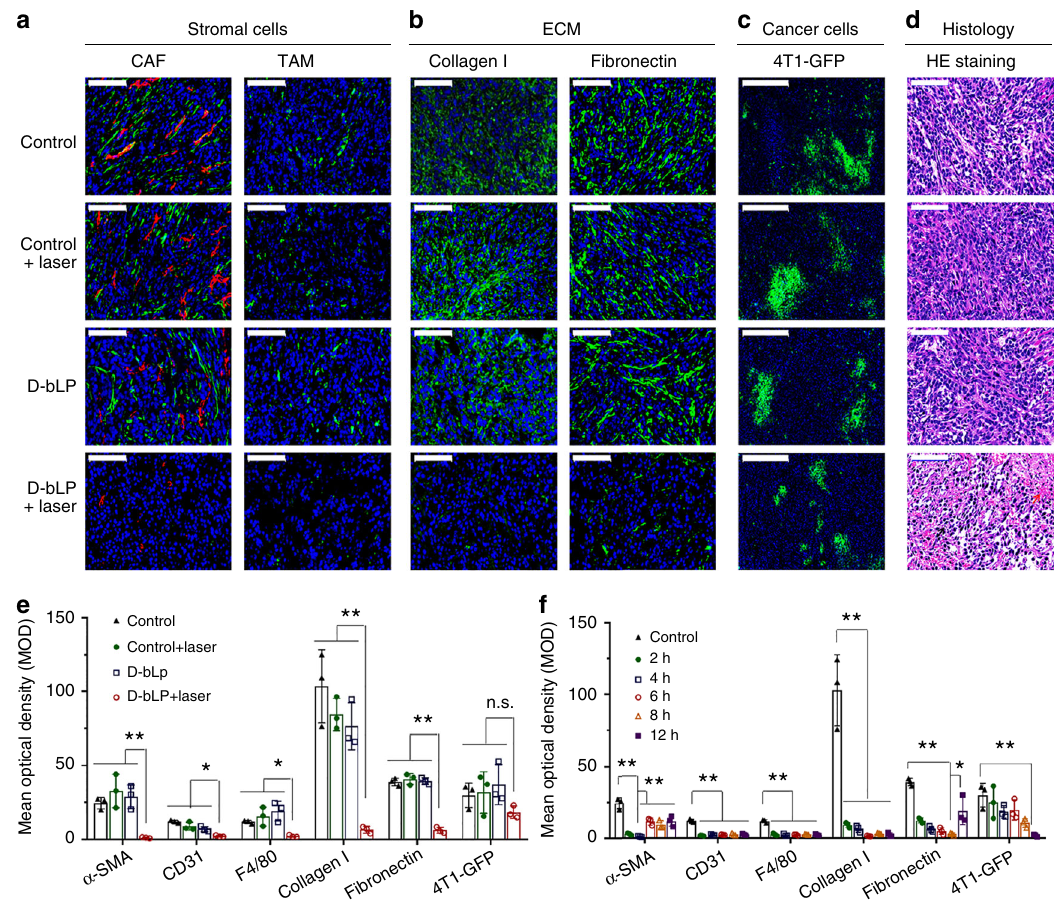
Fig. 4 Ef fi cient remodeling of TSM by D-bLP-mediated photothermal effects. At 12 -h post injection of D-bLP, one tumor was exposed to 808 -nm laser at 2.5 W cm − 2 for 5 min, and the other one was not irradiated. These tumor tissues were collected at 4 h after laser irradiation for further measurements ( a – e ). a Variation of CAF and TAM populations in tumor with and without laser irradiation, scale bar, 100 µ m. CAF were characterized by α -SMA + /CD31 − cells, which was denoted as cells with green signals, excluding red signals; TAM were presented as cells with green signals (F4/80). b Expression of collagen I and fi bronectin in tumor with and without laser irradiation (green signals), scale bar, 100 µ m. c Proportion of 4T1-GFP cancer cells (green signals) in tumor with and without laser irradiation, scale bar, 500 µ m. d Histological examinations of tumors with and without laser irradiation by hematoxylin and eosin (H&E) staining, scale bar, 100 µ m. Black arrow, karyopyknosis; red arrow, hemorrhage. e The quanti fi ed results of CAF, TAM, collagen I, fi bronectin, and 4T1-GFP cancer cells in tumor with and without laser irradiation ( n = 3). f Quanti fi ed variations of CAF, TAM, collagen I, fi bronectin, and 4T1-GFP cancer cells in the D-bLP + laser-treated group at different time points after laser irradiation ( n = 3). The data are means ± SD, * p < 0.05, ** p < 0.01, n.s. not signi fi cant (ANOVA and two-tailed Student ’ s t